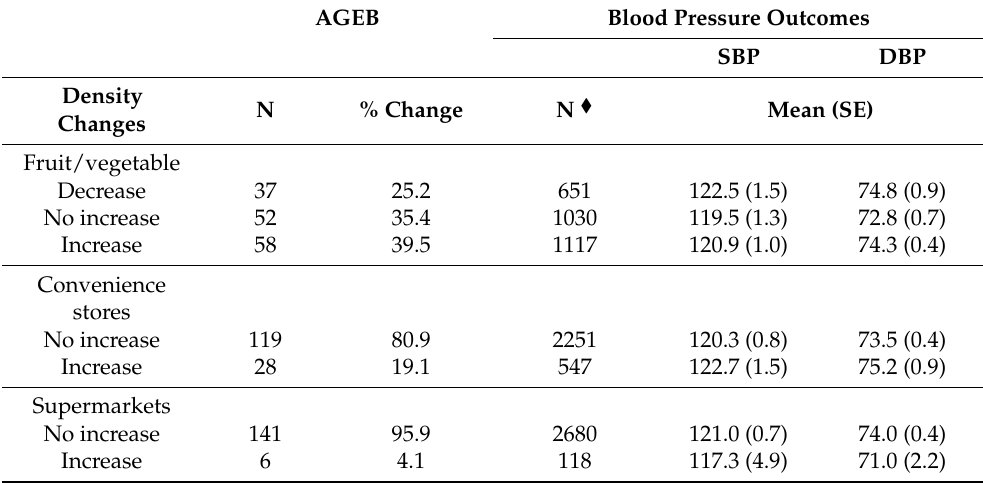
Table 2. Descriptive characteristics of neighborhood (AGEB, n = 147) food store density * changes (2010 to 2016) and corresponding individual-level ( n = 2798) systolic blood pressure (SBP) and diastolic blood pressure (DBP) outcomes in